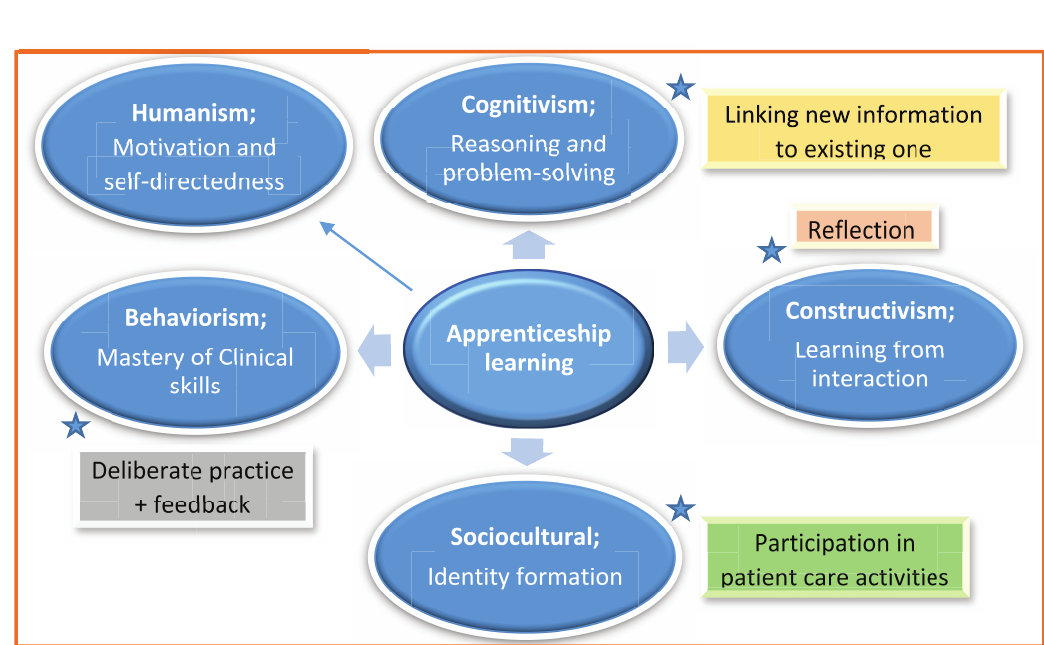
Figure 3: Integration of the learning